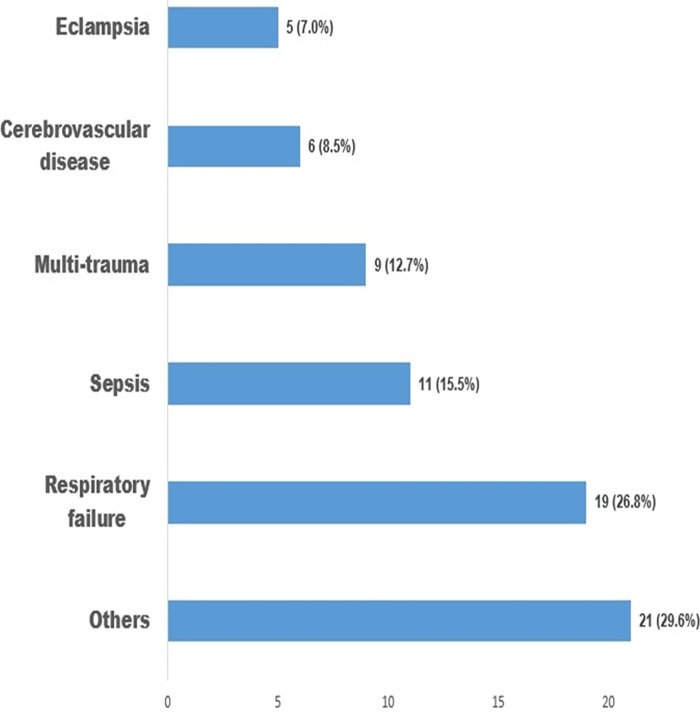
Admitting diagnosis of Patients in Intensive Care Unit of Lagos University Teaching Hospital, Lagos.“Others” as a group of admitting diagnosis included: post-surgical patients, patients with chronic renal failure and malignancies.